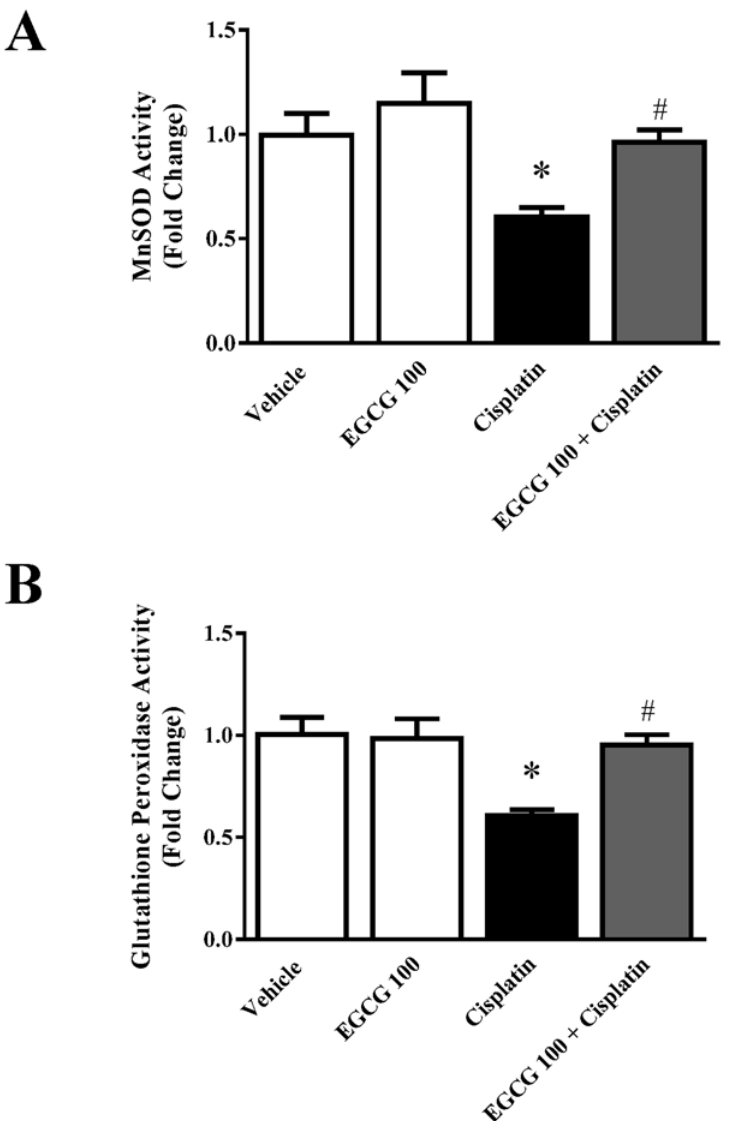
Fig 5. Effect of EGCG on cisplatin-induced nitrative stress in mice. Panel A. Histological examination revealed significant protein nitration in the renal tubules of the cisplatin-treated group. EGCG treatment reduced the level of protein nitration similar to vehicle level. Panel B. Quantitative measurement of 3-nitrotyrosine adducts in protein also demonstrated similar trend. Results are mean ± S.E.M. n = 4/group. * p < 0.05 versus vehicle; and # p < 0.05 versus